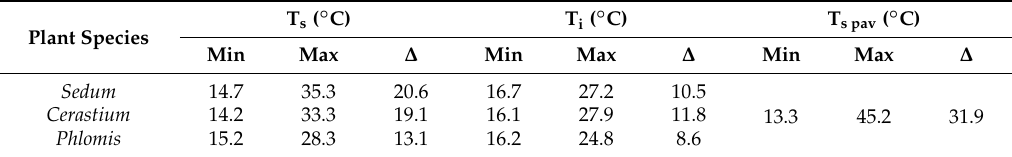
Table 9. Thermal gradients—4 August 2014.